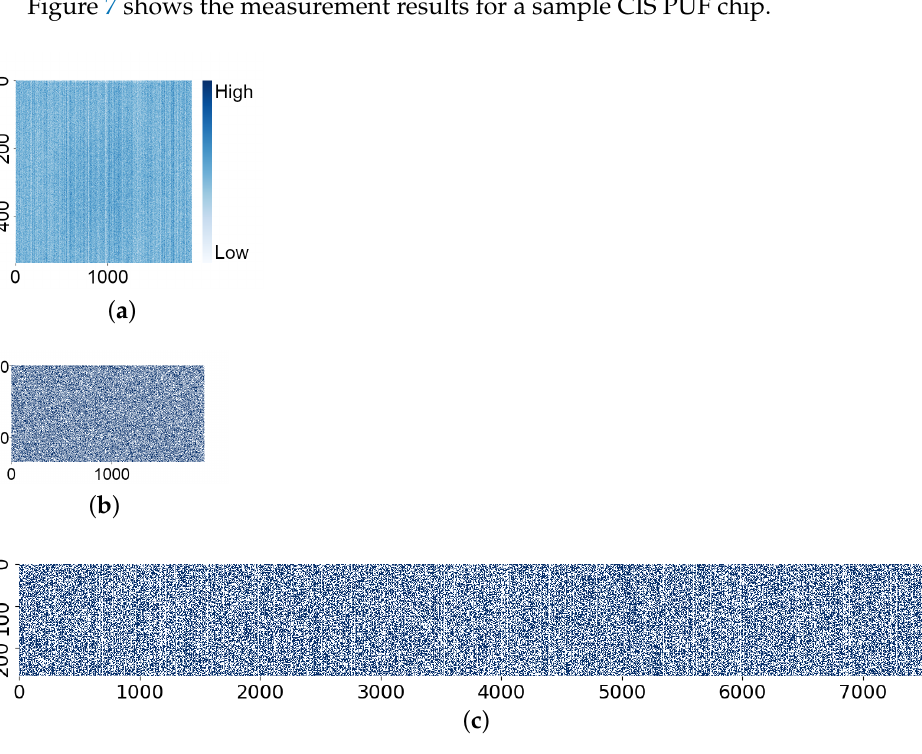
Figure 7. An example of SF cell and PUF response. ( a ) Heat-map diagram of SF cell output. ( b ) Heat- map diagram of basic PUF response. ( c ) Heat-map diagram of LG32 PUF